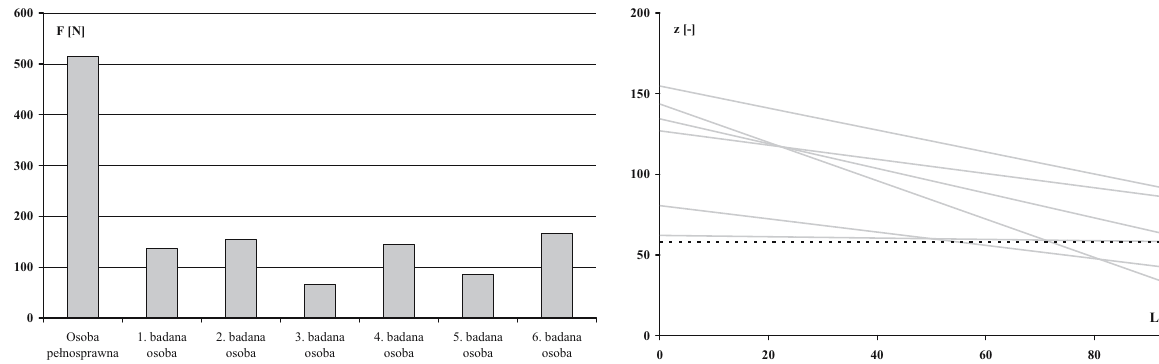
Figure 8: Comparison of the maximum pressure force on the hand - brake lever for a non - disabled person and for individual respondents.